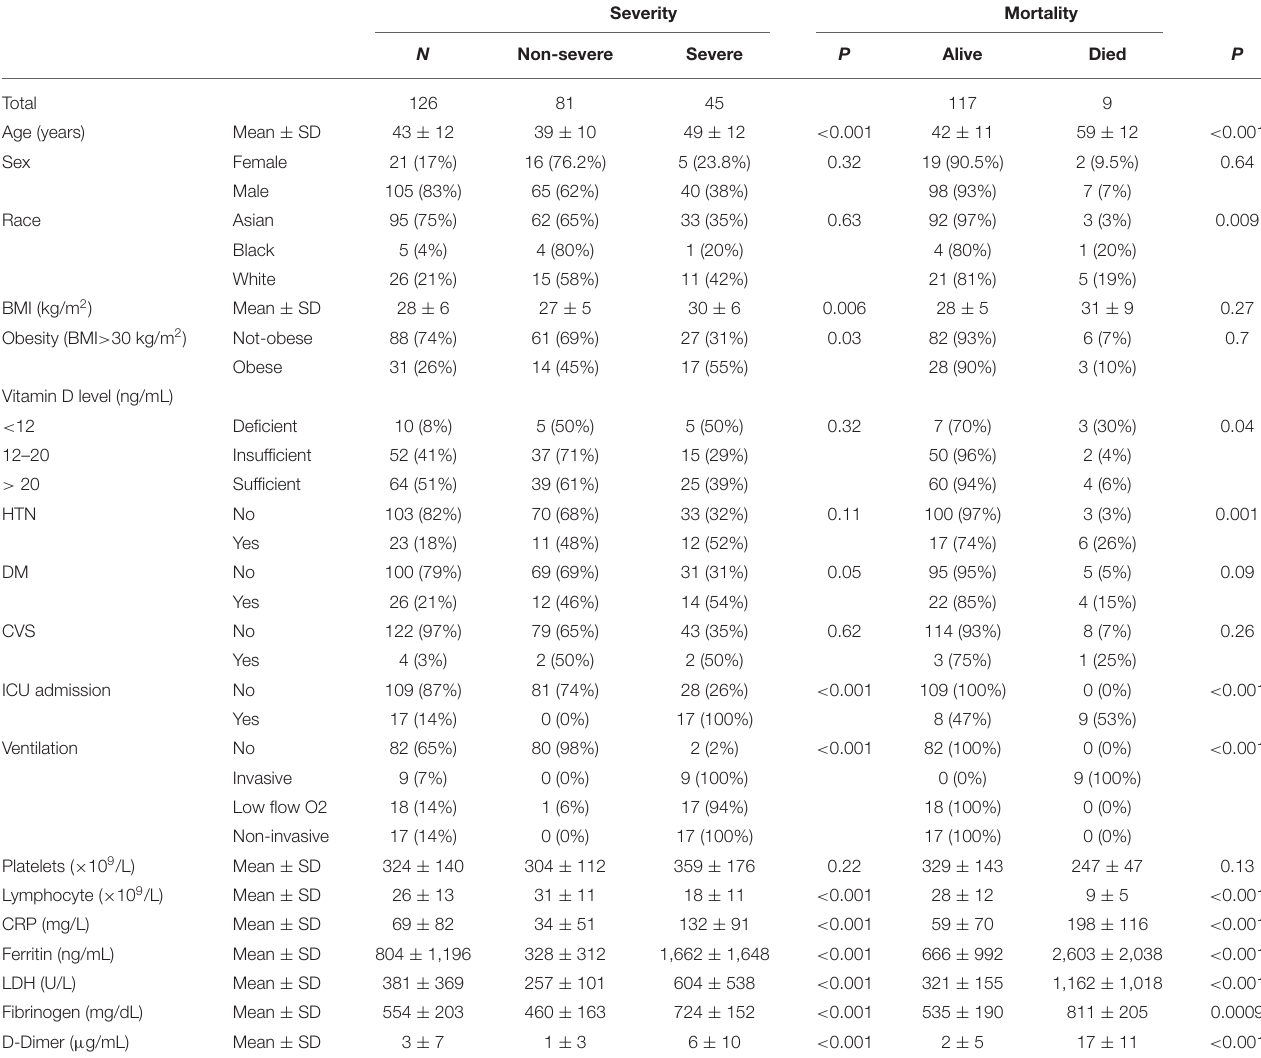
TABLE 1 | Characteristics of COVID-19 patients according to disease severity and mortality.